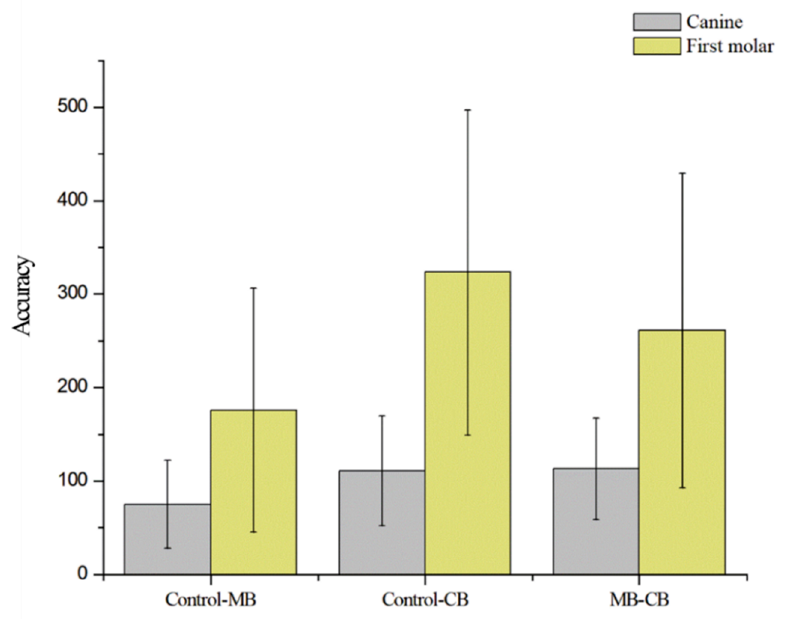
Table 2. Results of intra-rater reliability analysis for measured canine and first molar using ICC. 95% CI p -Value * Tooth ICC (2,1) Min Max Canine Right Measurements 0.990 0.940 1.000 0.000 Left Measurements 0.965 0.818 0.999 0.000 First molar Right Measurements 0.936 0.732 0.998 0.000 Left Measurements 0.933 0.719 0.998 0.000 * p < 0.05 by ICC. Min = minimum; Max = maximum; CI = confidence interval.